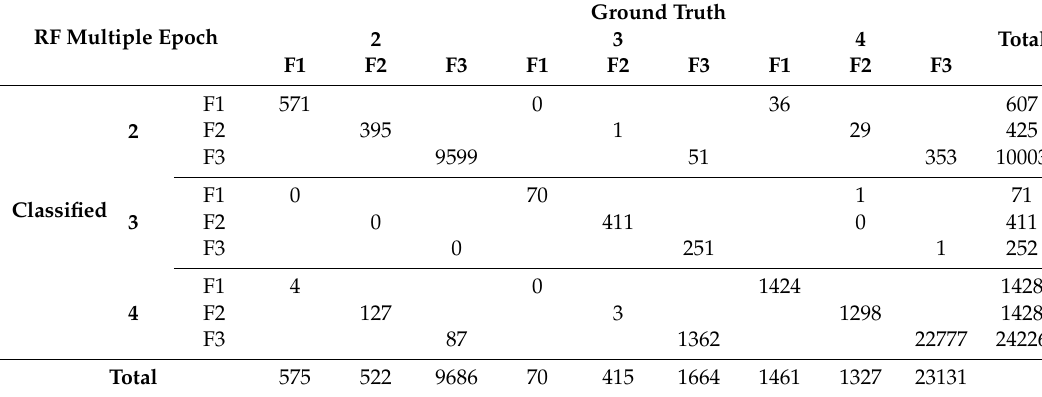
Table A6. Confusion matrix of multitemporal classification performed with the Random Forest (RF) classifier, F1 - farm 1, F2 - farm 2 and F3 - farm